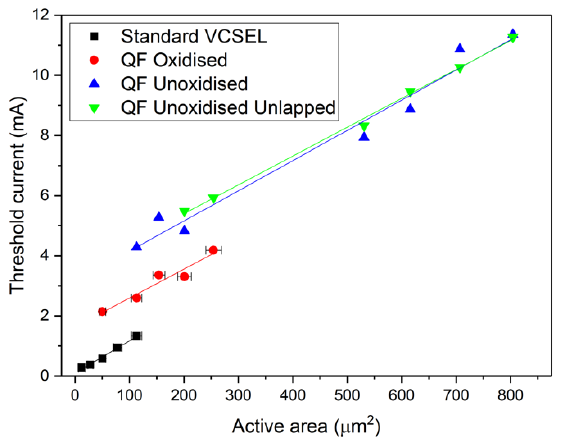
Figure 4. Lowest measured threshold currents as a function of active area.